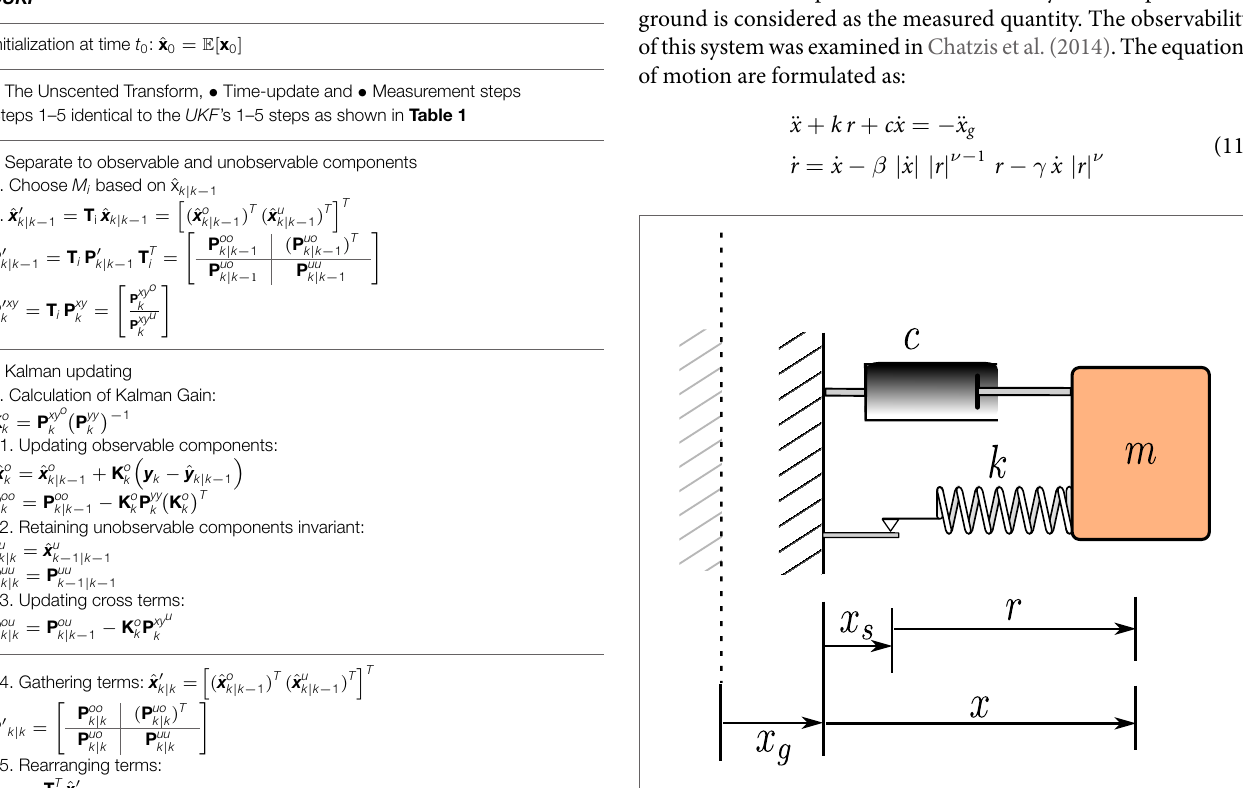
FIGURE 2 | Mass on a Bouc–Wen